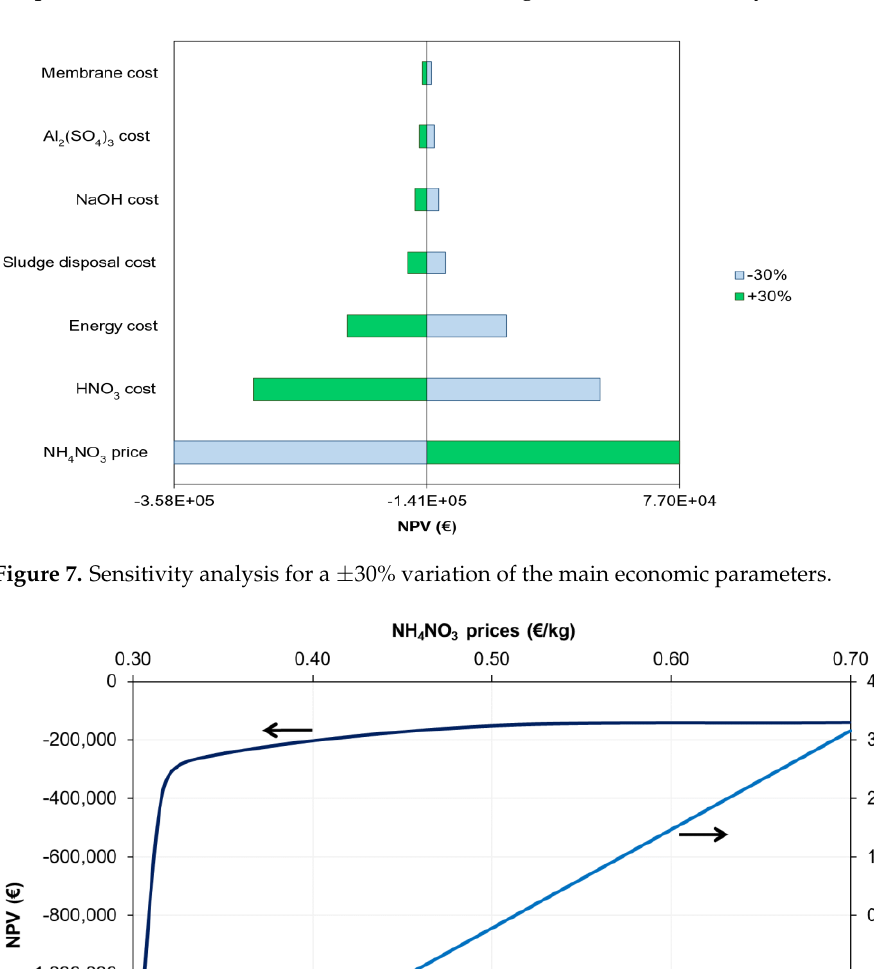
Figure 7. Sensitivity analysis for a ±30% variation of the main economic parameters .